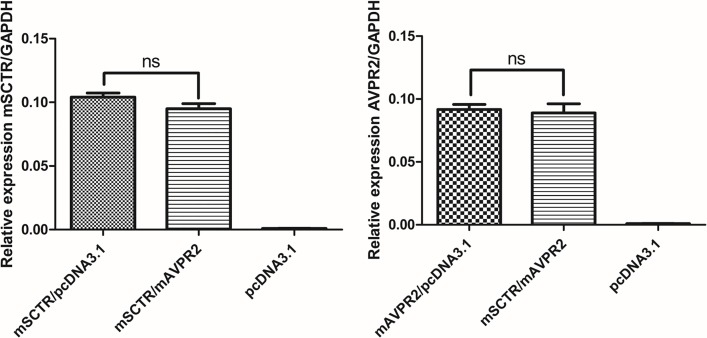
Comparable transcript levels of mSCTR and mAVPR2 in CHOK1 cells transiently transfected with combinations of mSCTR and mAVPR2 by quantitative real-time PCR.The total receptor gene transcript levels were compared to the internal house-keeping control GAPDH by the 2 ΔΔ ct method. There is no significant difference among the groups. mSCTR/pcDNA3.1, 1ug mSCTR plasmid with 1ug pcDNA 3.1 empty vector; mSCTR/mAVPR2, 1ug receptor plasmid each; pcDNA3.1, 2ug pcDNA3.1; mAVPR2/pcDNA3.1, 1ug mAVPR2 plasmid with 1ug pcDNA 3.1. Data are presented as means ± SEM from three independent experiments in duplicate. ns, not significant.